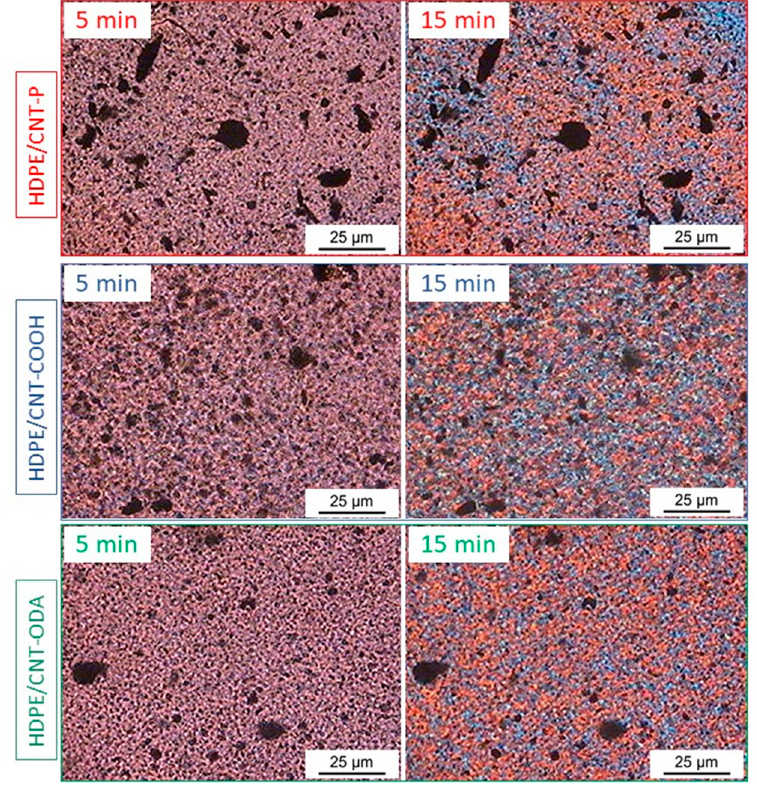
Figure 9. POM images of HDPE/CNT nanocomposites at 127 °C isotherm.